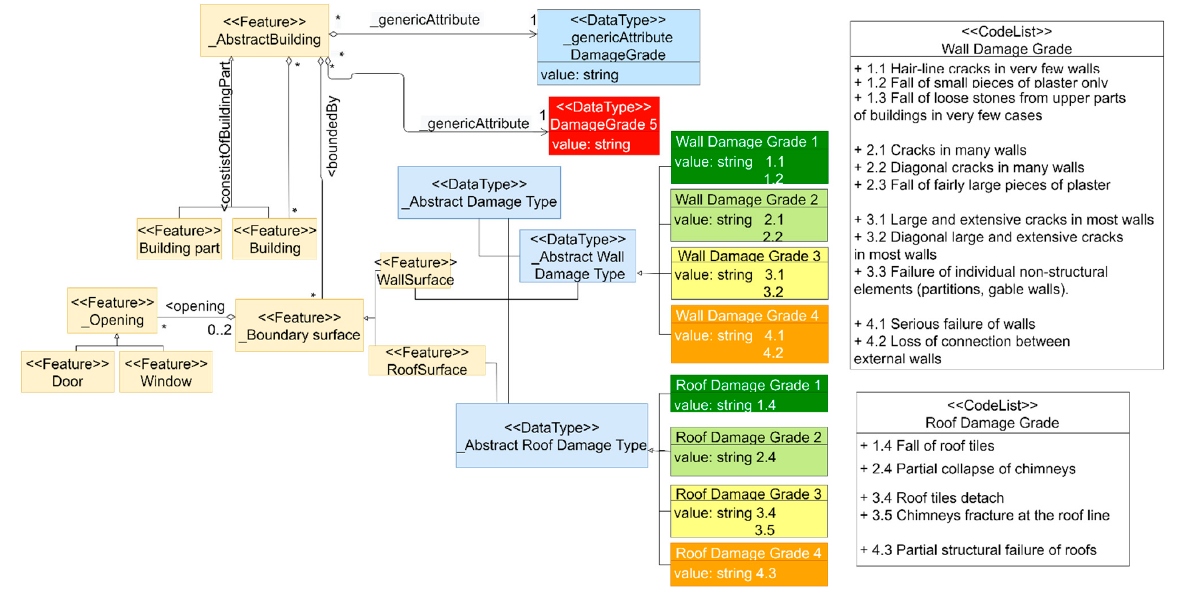
Figure 7. UML class diagram of the CityGML feature structure of basic semantic LOD3 building model, extended with DamageGrades.